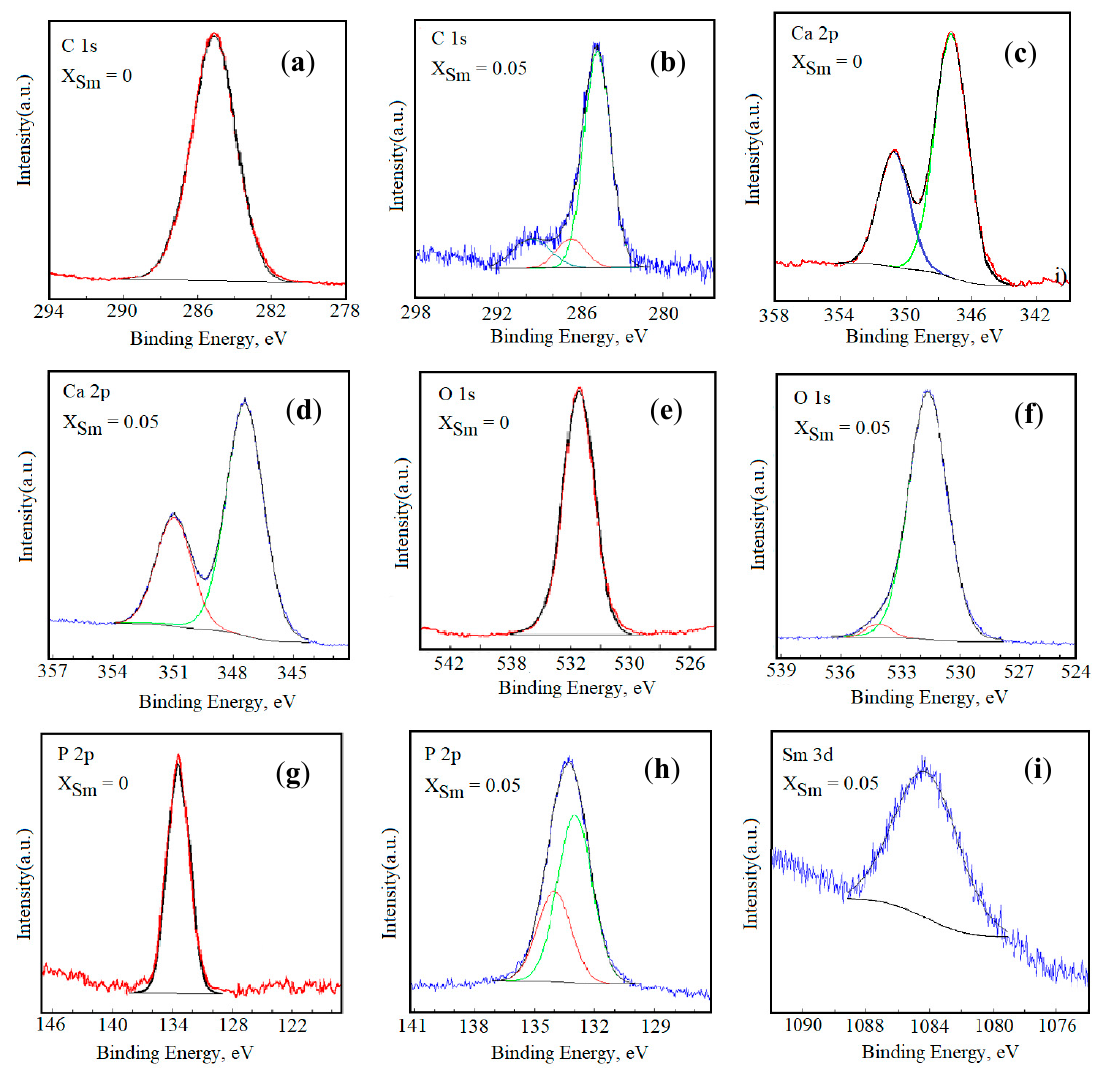
Figure 8. Deconvolution of XPS peaks of C 1 s , O 1 s , Ca 2 p , P 2 p and Sm 3 d for the pure HAp ( a , c , e , g ) and 5SmHAp ( b , d , f , h , i ) coatings.